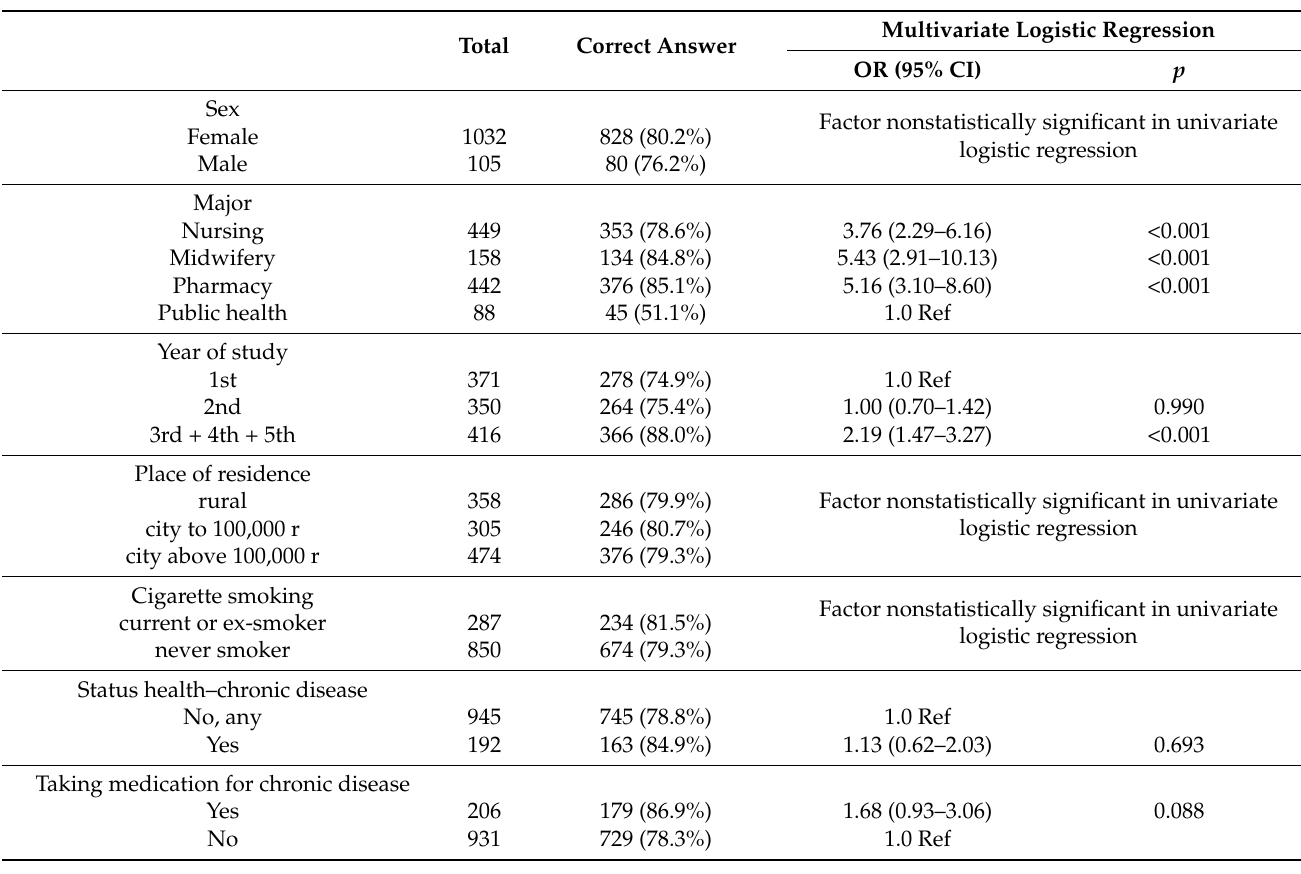
Table 4. Associations between the demographic factors (sex, major, year of study, place of residence, smoking cigarettes, status health, taking medication, and vaccination status) and student knowledge about the flu vaccination frequency.